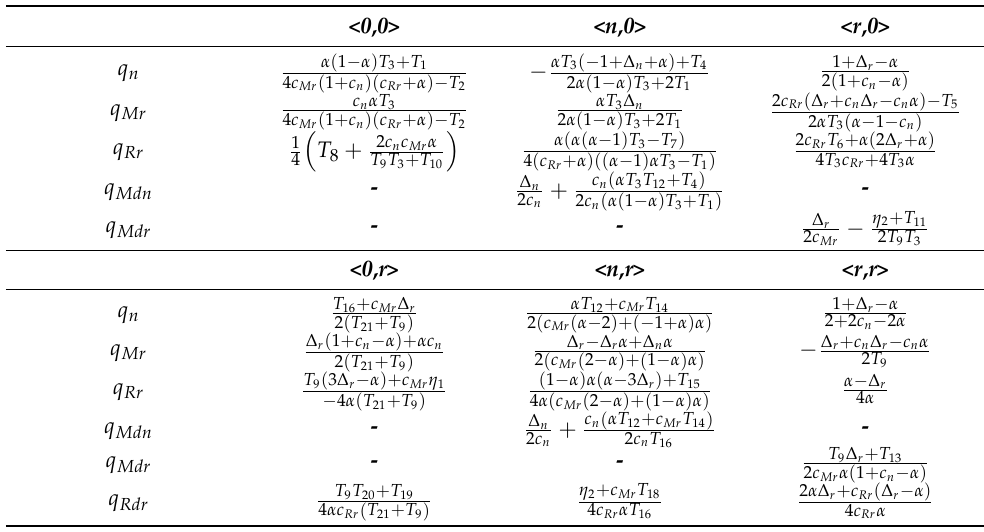
Table 4. Optimal decisions in each